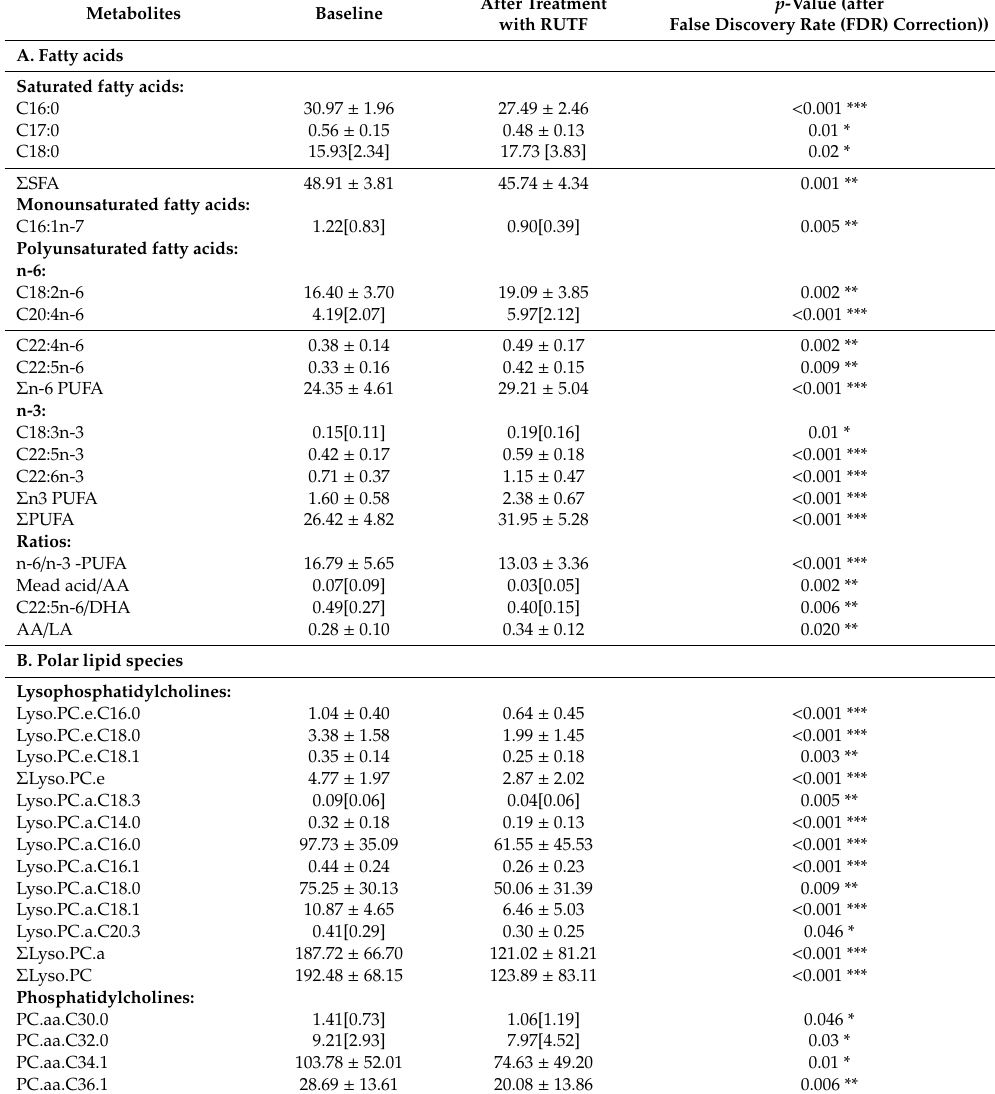
Table 4. Metabolites ( A ) Total glycerophospholipid Fatty acids ( B ) polar lipid species identified as significant features between lipid profiles of severe malnourished children (n = 41), pre- and post- treatment with